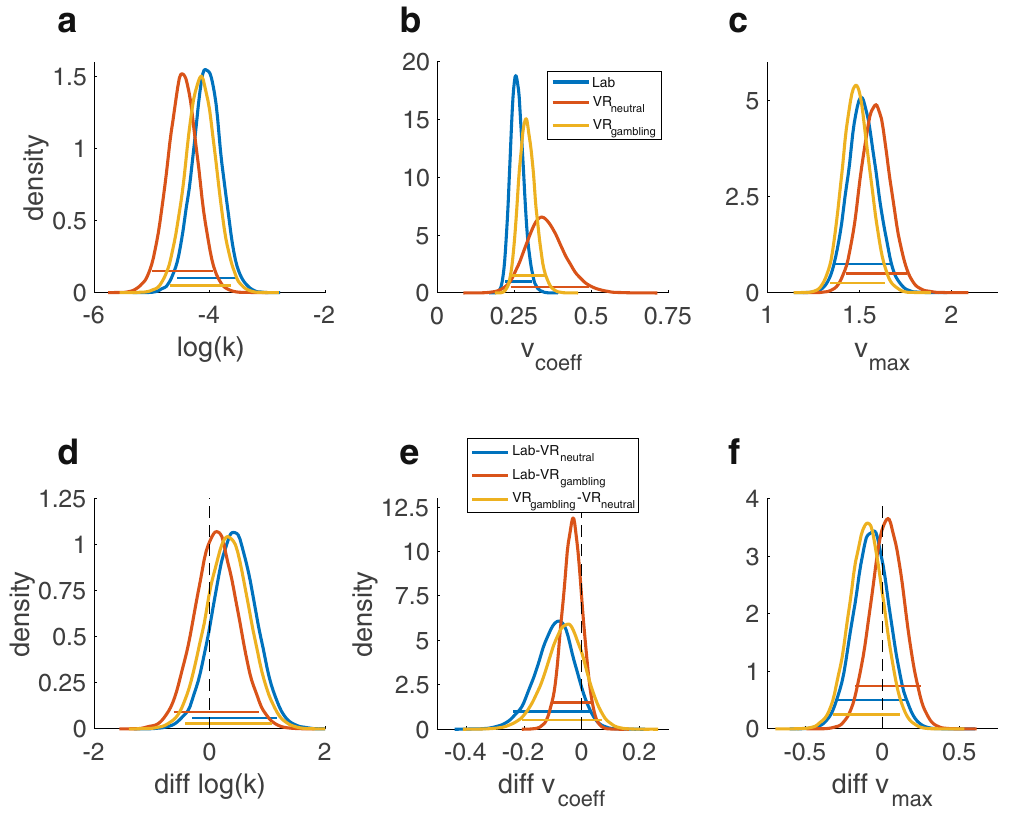
Figure 4. Posterior distributions of the parameters of the DDM S model. Colored bars represent the corresponding 95% HDIs. ( a ) Posterior distributions of the log(k) parameter for all three sessions. ( b ) Posterior distributions of the v coeff parameter (mapping the drift rate onto the trial wise value difference). ( c ) Posterior distributions of the v max parameter (setting an asymptote for the relation between the trial wise value difference and the drift rate). ( d ) Pairwise difference distributions between the posterior distributions of the log(k) parameters of the three sessions. ( e ) Pairwise difference distributions between the posterior distributions of the v coeff parameters of the three sessions. ( f ) Pairwise difference distributions between the posterior distributions of the v max parameters of the three sessions.